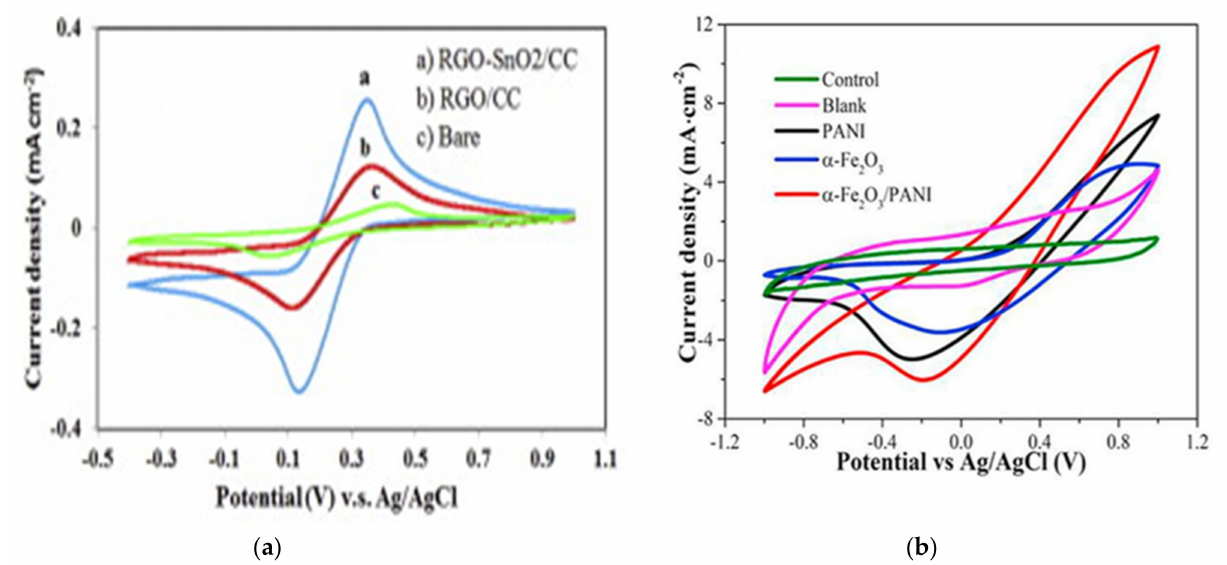
Figure 11. ( a ) Cyclic voltammograms of the bare CC, RGO/CC, and RGO–SnO 2 /CC electrodes in 10 mM K 3 [Fe(CN) 6 ] containing 0.1 M KCl (scan rate: 0.1 V/s). Reproduced with permission from [153] ( b ) Cyclic voltammetry curves with a potential range from − 1.0 V to 1.0 V of various cathodes at the scanning rate of 1 mV/s in catholyte. Reproduced with permission from [165].